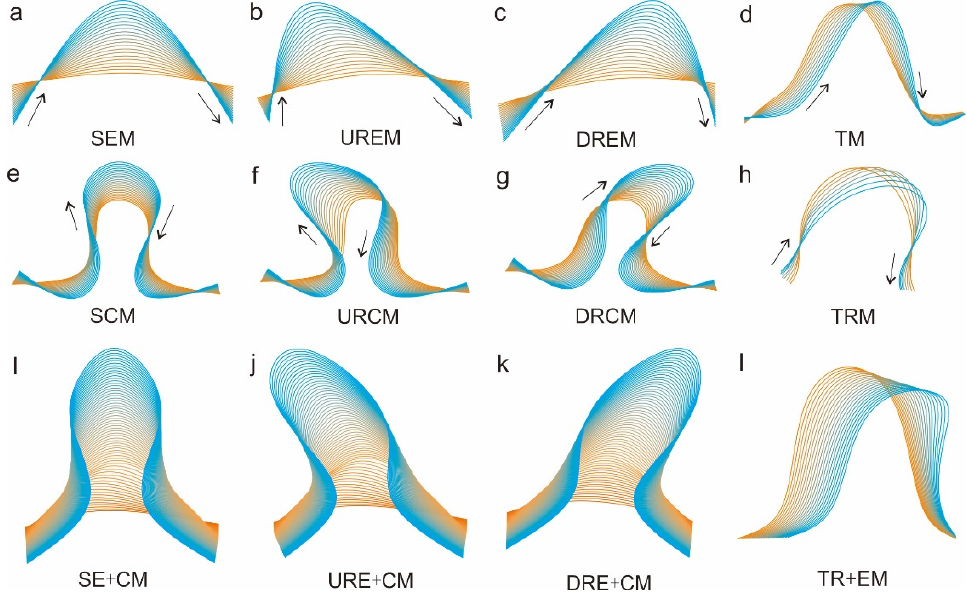
Figure 1. Typical planform migration modes, depicting the migration track of river channel. ( a ) symmetrical expansion migration; ( b ) upstream + rotation expansion migration; ( c ) downstream + rotation expansion migration; ( d ) translation migration; ( e ) symmetrical contraction migration; ( f ) upstream + rotation contraction migration; ( g ) downstream + rotation contraction migration; ( h ) translation rotation migration; ( i ) symmetrical expansion + contraction migration; ( j ) upstream rotation expansion + contraction migration; ( k ) downstream rotation expansion + contraction migration; ( l ) translation rotation + expansion migration.